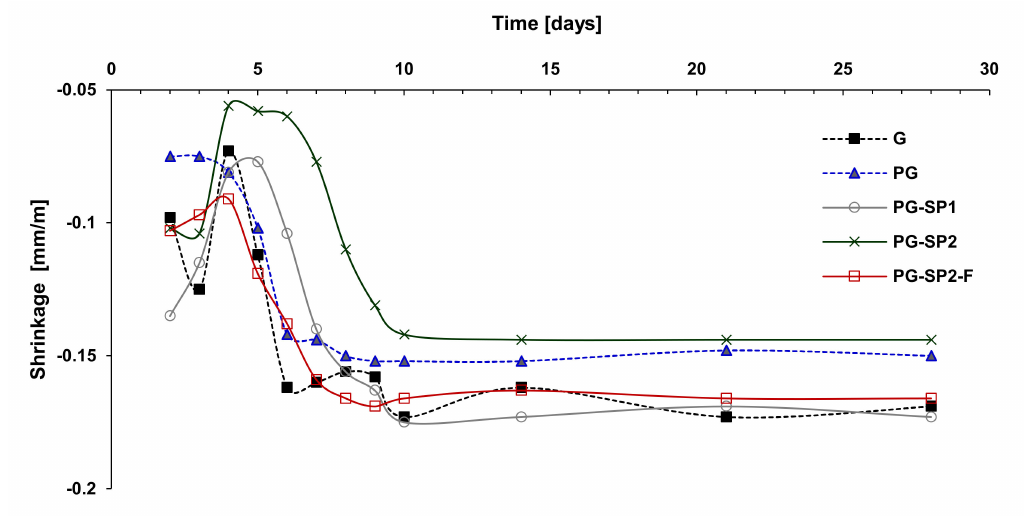
Figure 3. The shrinkage of modified gypsum plasters during 28 days of